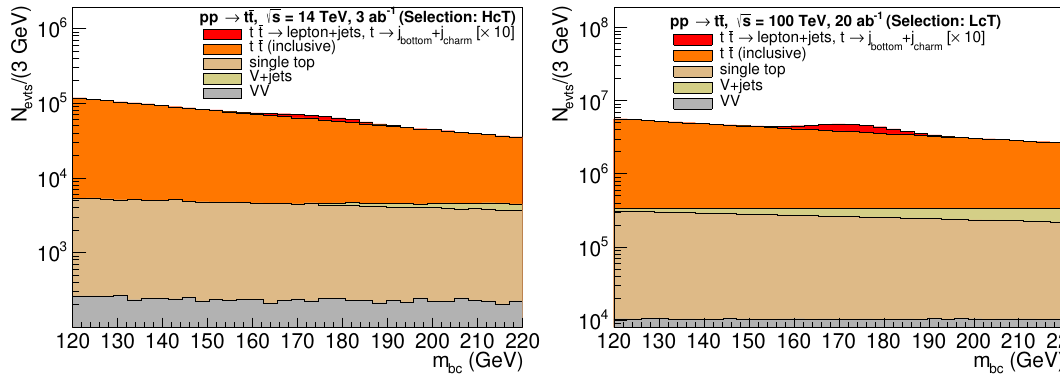
Figure 2 . Expected invariant mass distributions for pairs of charm and bottom jets reconstructed passing the analysis criteria for the t ! b c analysis simulated for signal and backgrounds in pp p collisions at s = 14 TeV (left) and 100 TeV (right) for the ‘HcT’ and ‘LcT’ charm jet reconstruction performances, respectively, described in the text. The di(cid:11)erent histograms show the Gaussian signal (red, scaled by a factor of 10 for visibility) and individual (exponential-like) backgrounds, stacked one above each other, listed in table